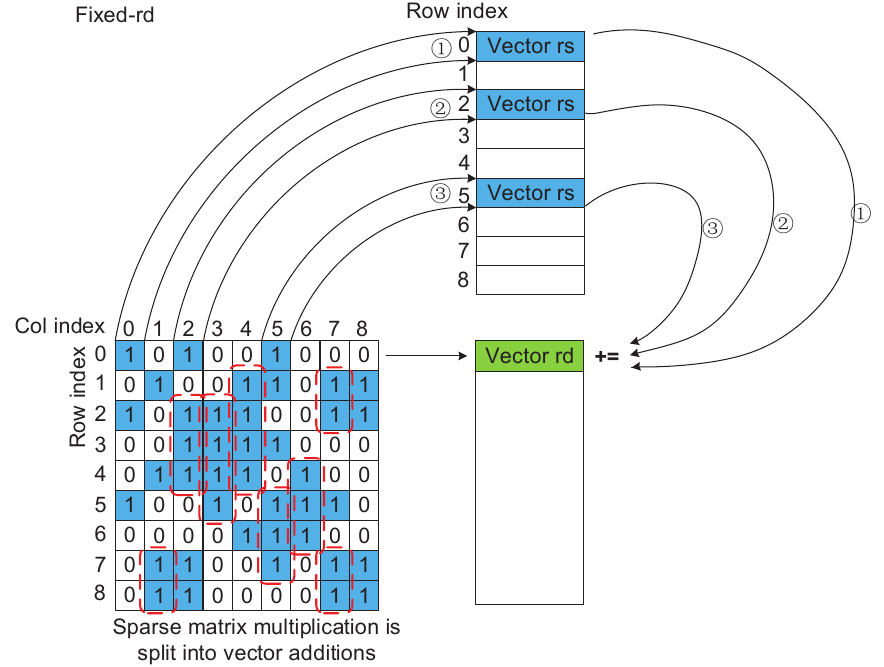
Figure 26. The data locality of aggregation in GCNs. The numbers in circle indicate the computation order.